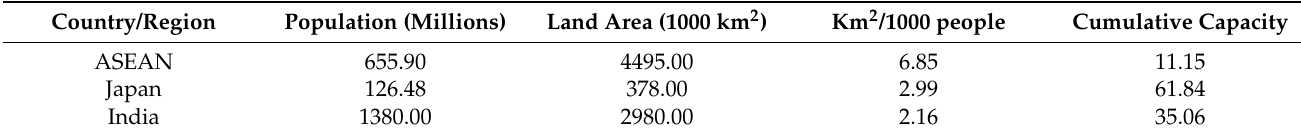
Table 3. Land resource comparative advantage of the Association of Southeast Asian Nations (ASEAN) compared with Japan and India.